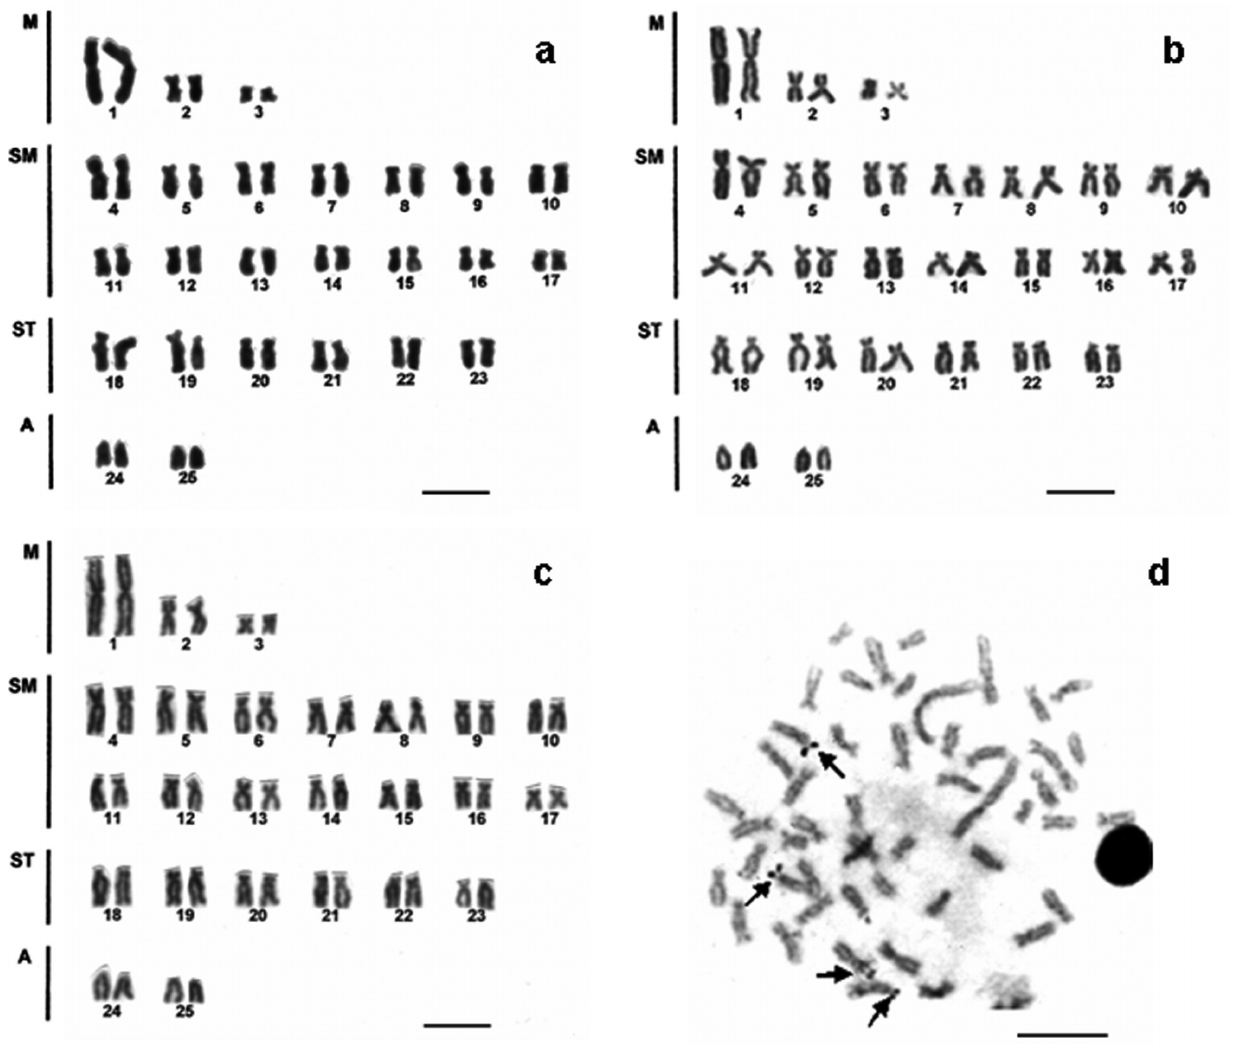
Fig. 3. Giemsa-stained karyotypes of Astyanax aff. bimaculatus (2n = 50, FN = 96) from sites A (a), B (b) and C (c). In (d), a somatic metaphase after silver nitrate staining in a specimen from Contas River, showing four positive signals (arrows). The bar equals